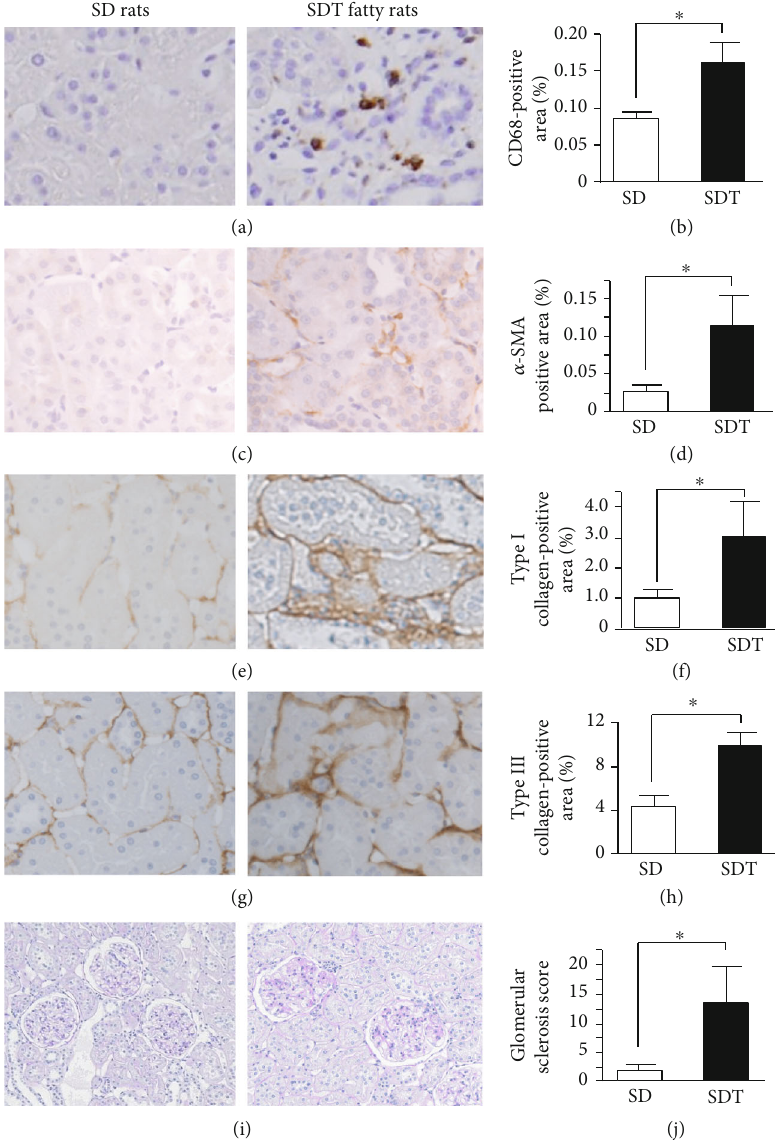
Figure 2: Histological evaluation of the kidney in SD and SDT fatty rats. Immunohistological staining of kidney tissues using antibodies against CD68 (a, b), α -SMA (c, d), type I collagen (e, f), and type III collagen (g, h). Histological PAS staining showing focal glomerular sclerosis (i) and semiquantitative assessment of focal glomerular sclerosis (j). Original magni fi cation: × 100. Values are presented as the mean ± SEM . ∗ p < 0 : 05 vs. SD